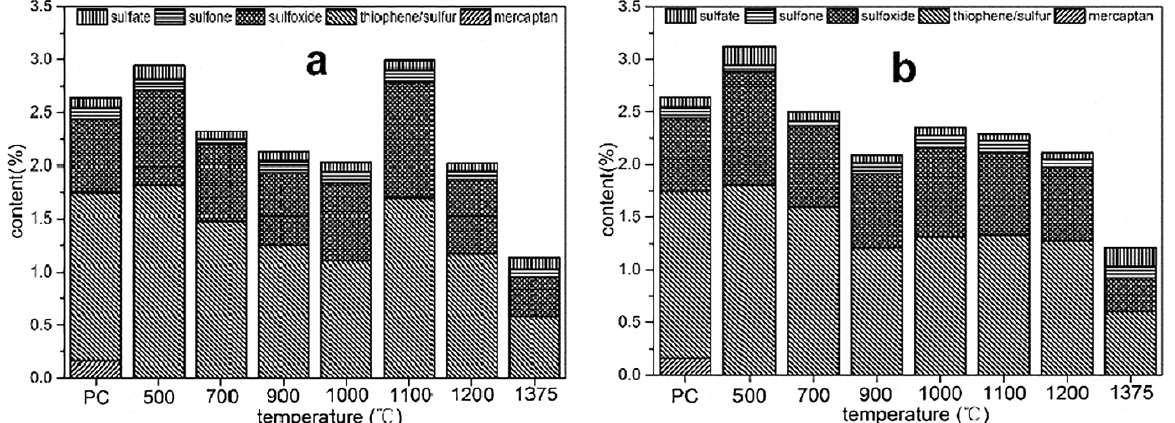
Figure 3. The distribution of sulfur forms on the surface of petroleum coke varies with temperature under different heating rates; ( a ) 10 K/min; ( b ) 30 K/min [49] . Reprinted/adapted with permission from Ref. [49]. 2021, Fuel.